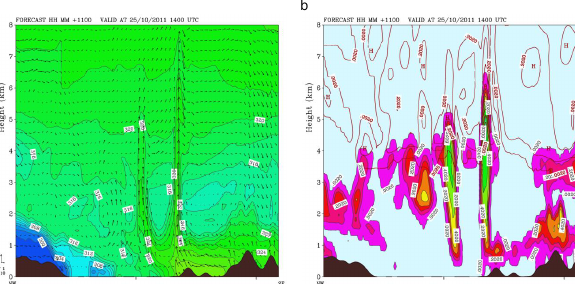
Figure 11. Cross sections taken along the segment shown in figure 1, for the CT event at 14 UTC of Oct. 25. a: equivalent potential temperature and tangent flow component; b: cloud water (coloured, contour interval 0.1 g/kg) and cloud ice (solid contours, same interval).